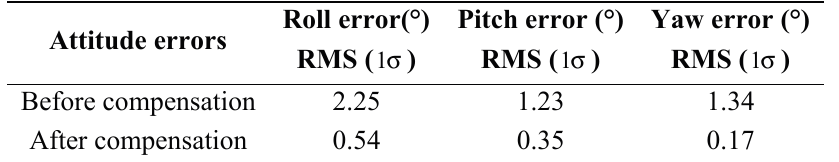
Table 2. Comparison between gyro g-sensitivity errors before compensation and after compensation on estimation of attitude